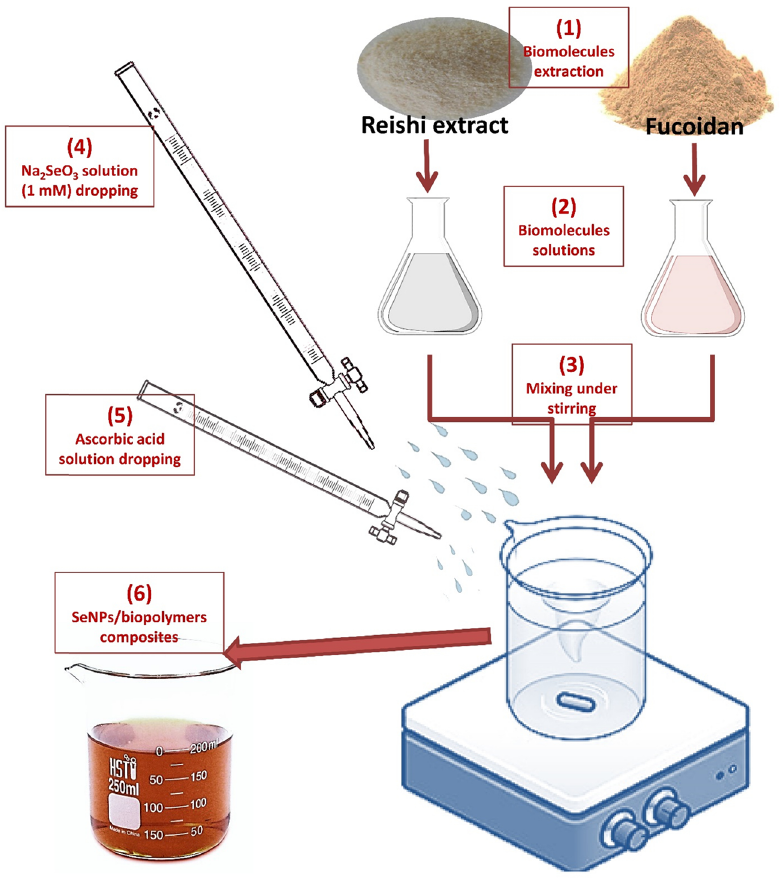
Figure 1: A systematic schematic protocol involved in the synthesis of decorated